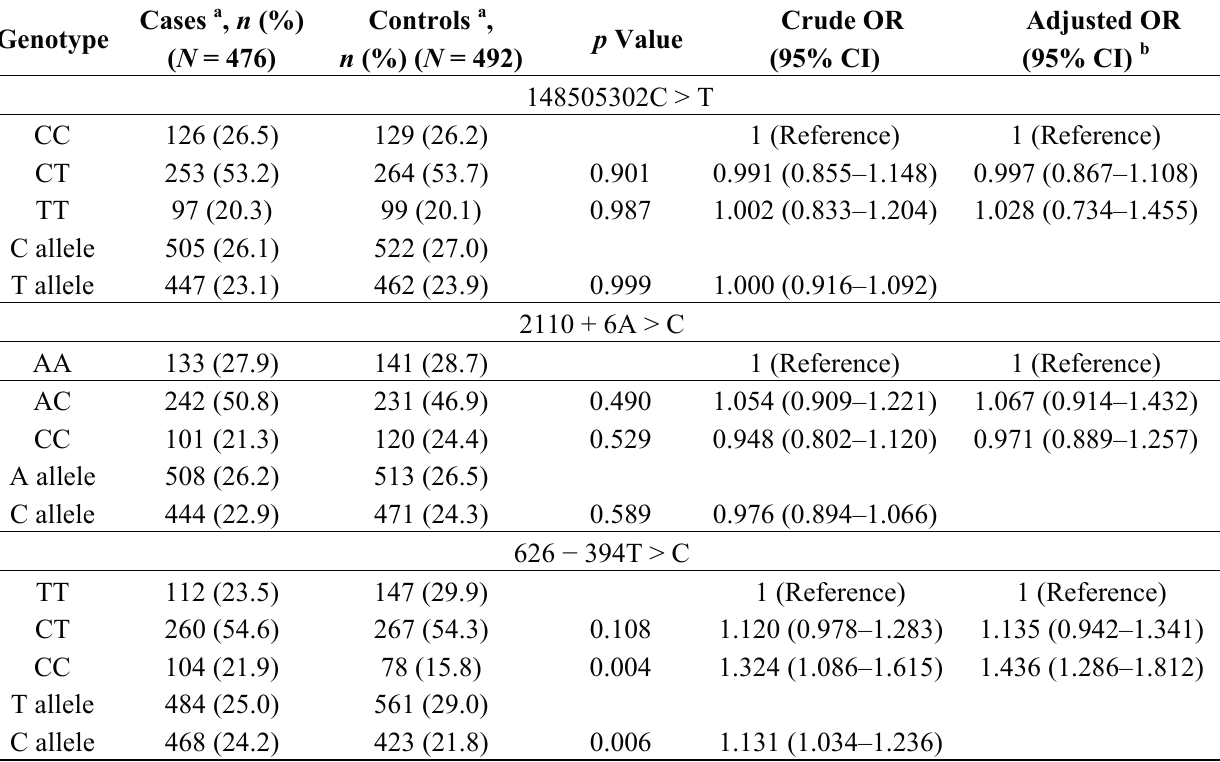
Table 2. Association between EZH2 gene 148505302C > T, 2110 + 6A > C and 626 − 394T > C polymorphisms and